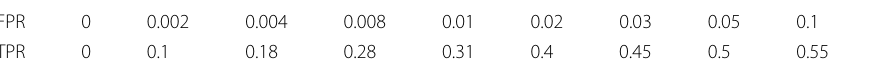
Table 4 Support points for the cubic spline construction of the ROC curve